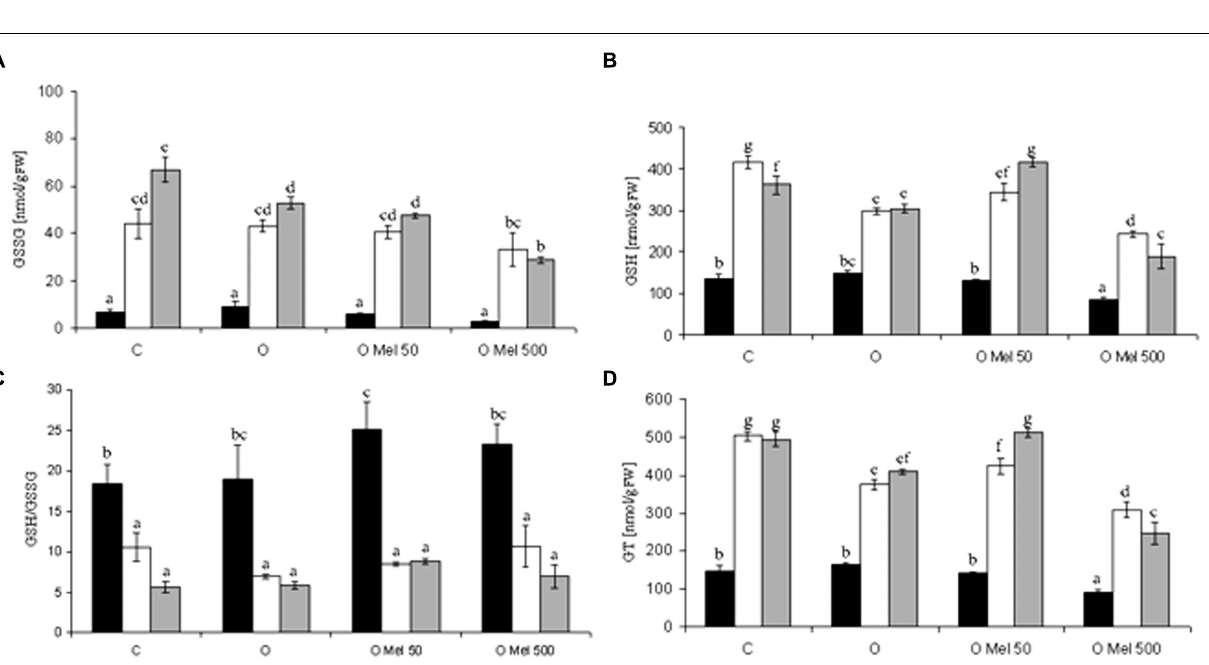
Frontiers in Plant Science |